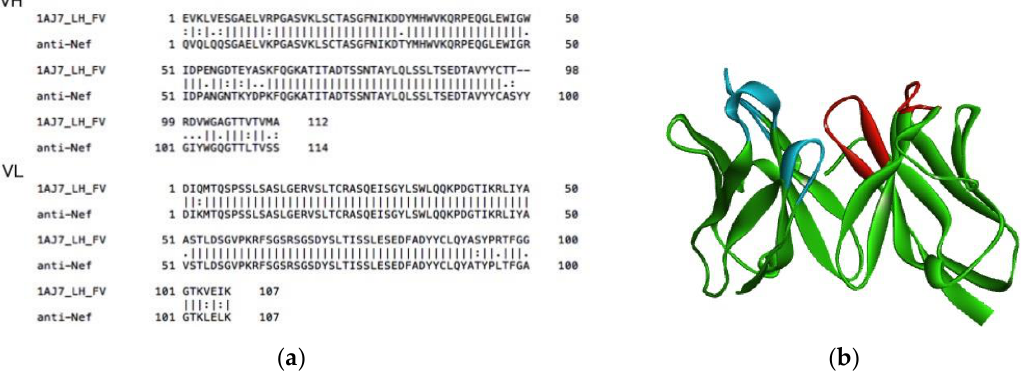
Figure 1. The structure of the anti-Nef antibody as predicted using homology modeling. ( a ) Alignment of the anti-Nef antibody and template (PDB code 1AJ7). ( b ) Model of the anti-Nef antibody. Green: framework, Blue: complementarity-determining region (CDR) of VH, Red: CDR of VL.